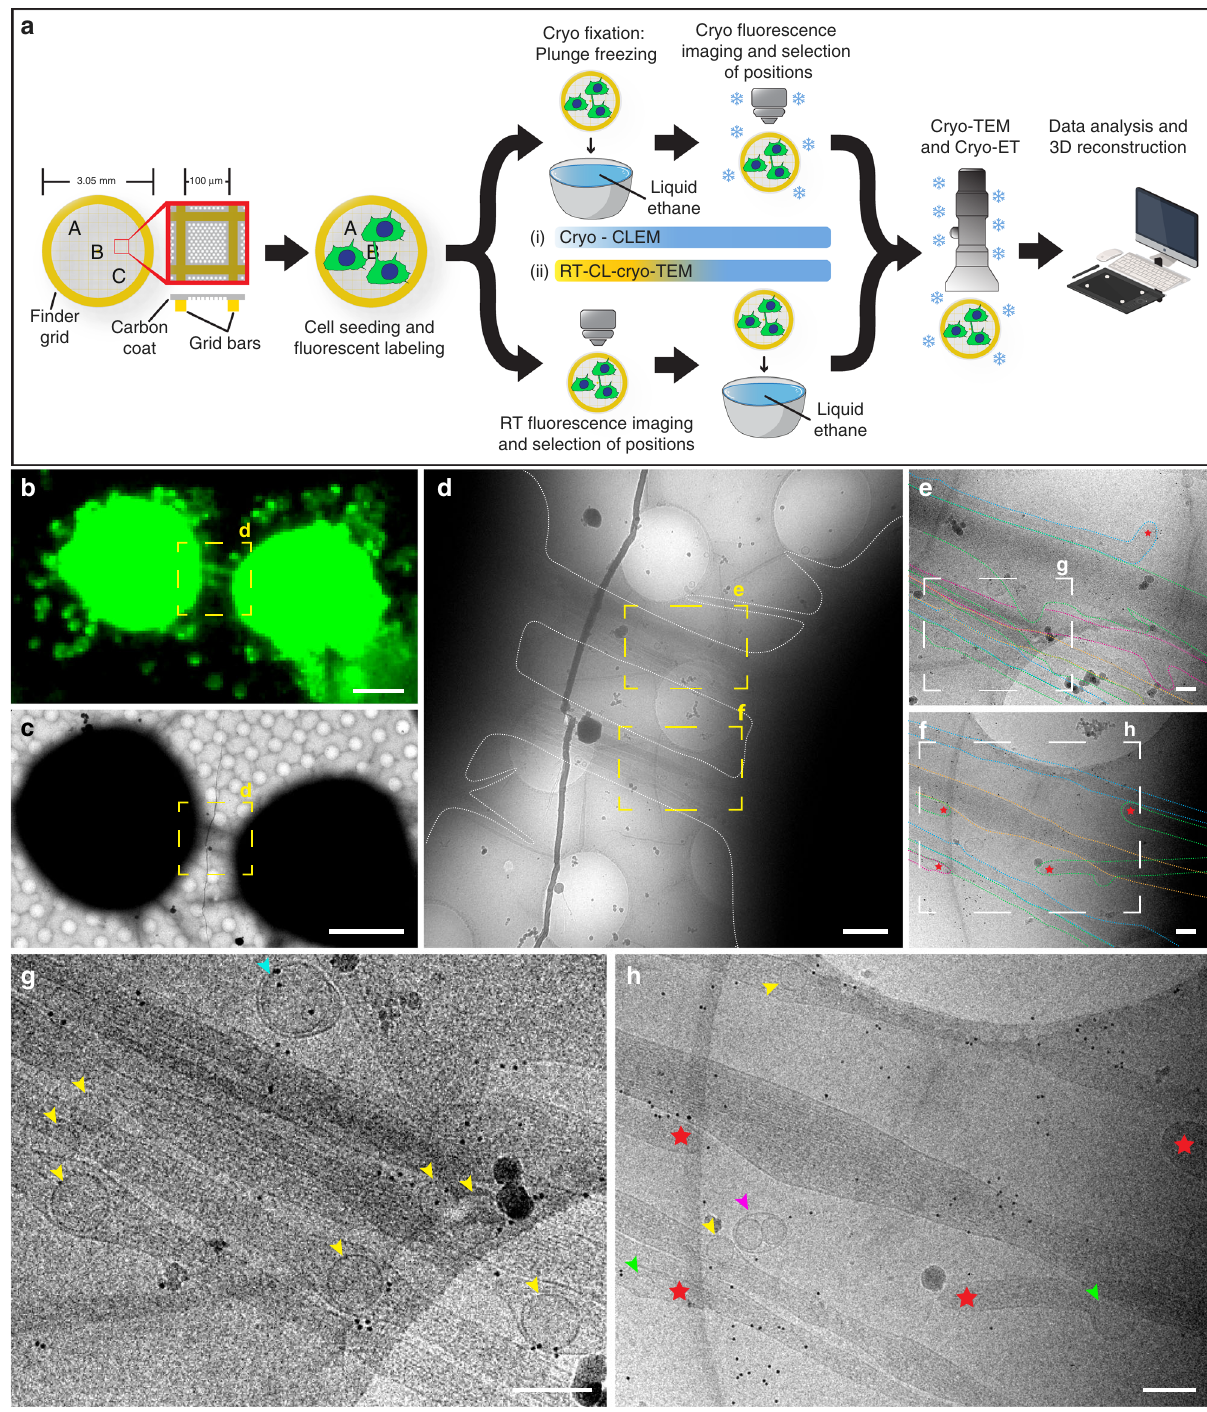
Fig. 1 Correlated light and cryo-electron microscopy strategies reveal individual TNTs. a A schematic diagram of the experimental work fl ow and approaches used to observe TNT-connected CAD cells by cryo-TEM. b Cryo-FM image of two CAD cells connected by a TNT stained with WGA (green). c Cells in b observed in cryo-TEM at low magni fi cation. Yellow dashed squares in b , c are shown at intermediate magni fi cation in d . Yellow dashed rectangles in d are shown at high magni fi cation in e and f , respectively. The plasma membrane of individual TNTs (iTNTs) were drawn with dotted colored lines in e and f to show membrane boundaries. Enlargements of white dashed rectangles in e and f are shown in g and h , respectively. g , h Various vesicular compartments were observed within and between iTNTs: yellow arrowheads show single vesicles; pink arrowheads show vesicles surrounded by an outer membrane; turquoise arrowheads show vesicles enclosed by a double membrane. Red stars in e , f , and h show tips of iTNTs extending/retracting from neighboring cells. Green arrows indicate vesicles inside extending/retracting iTNT tips observed in h . Scale bars: b , c , 10 μ m; d , 1 μ m; e – h , 200